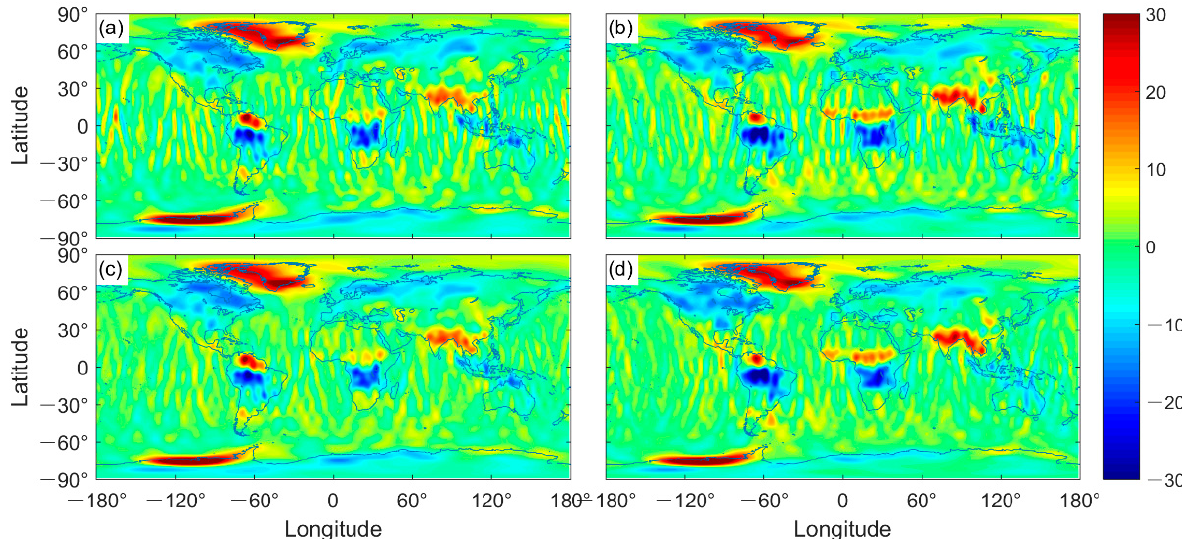
Figure 9. Spatial distributions of temporal signals from SOL01 and SOL02 solutions in August 2006 and September 2006 (EWH in cm) ( a ) SOL01 in August 2006, ( b ) SOL01 in September 2006, ( c ) SOL02 in August 2006, and ( d ) SOL02 in September 2006.